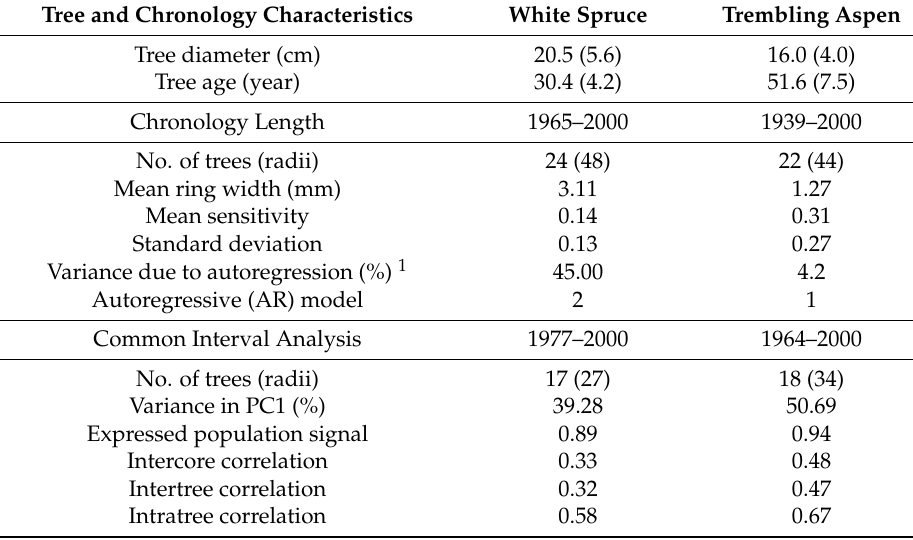
Figure 2. ( a ) The residual chronology of white spruce (1965–2000); ( b ) The residual chronology trembling aspen (1939–2000). The corresponding sample size (N, number of tree cores) is provided. Table 1. General tree characteristics (mean and standard deviation in parenthesis) and statistics of the residual chronology of white spruce and trembling aspen.